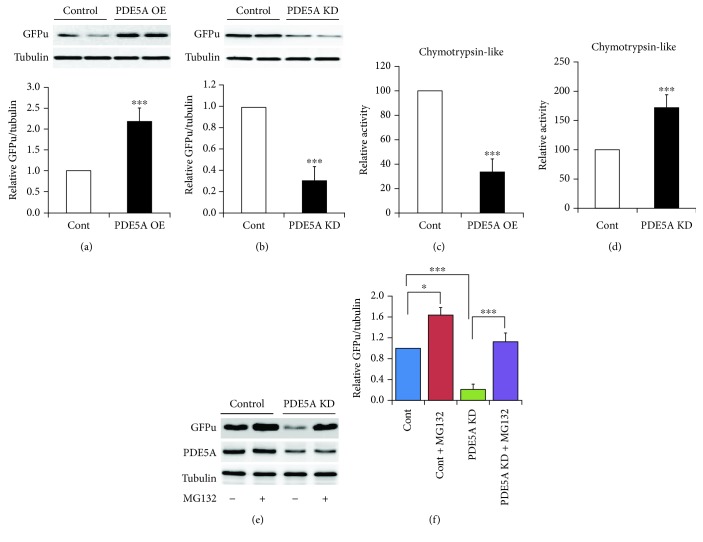
Effects of PDE5A on the proteasome activity in C2C12 myotubes. (a) Effects of PDE5A overexpression (OE) on the GFPu protein levels; (b) effects of PDE5A knockdown (KD) on the GFPu protein levels; (c) effects of PDE5A overexpression on the chymotrypsin-like activity of proteasome; (d) effects of PDE5A knockdown on the chymotrypsin-like activity of proteasome. (e) Representative western blots showing the effects of proteasome inhibitor MG132 on the GFPu protein levels; (f) quantification of the GFPu protein levels in (e). N = 4. ∗P < 0.05, ∗∗∗P < 0.001 vs. the control group or the indicated group.